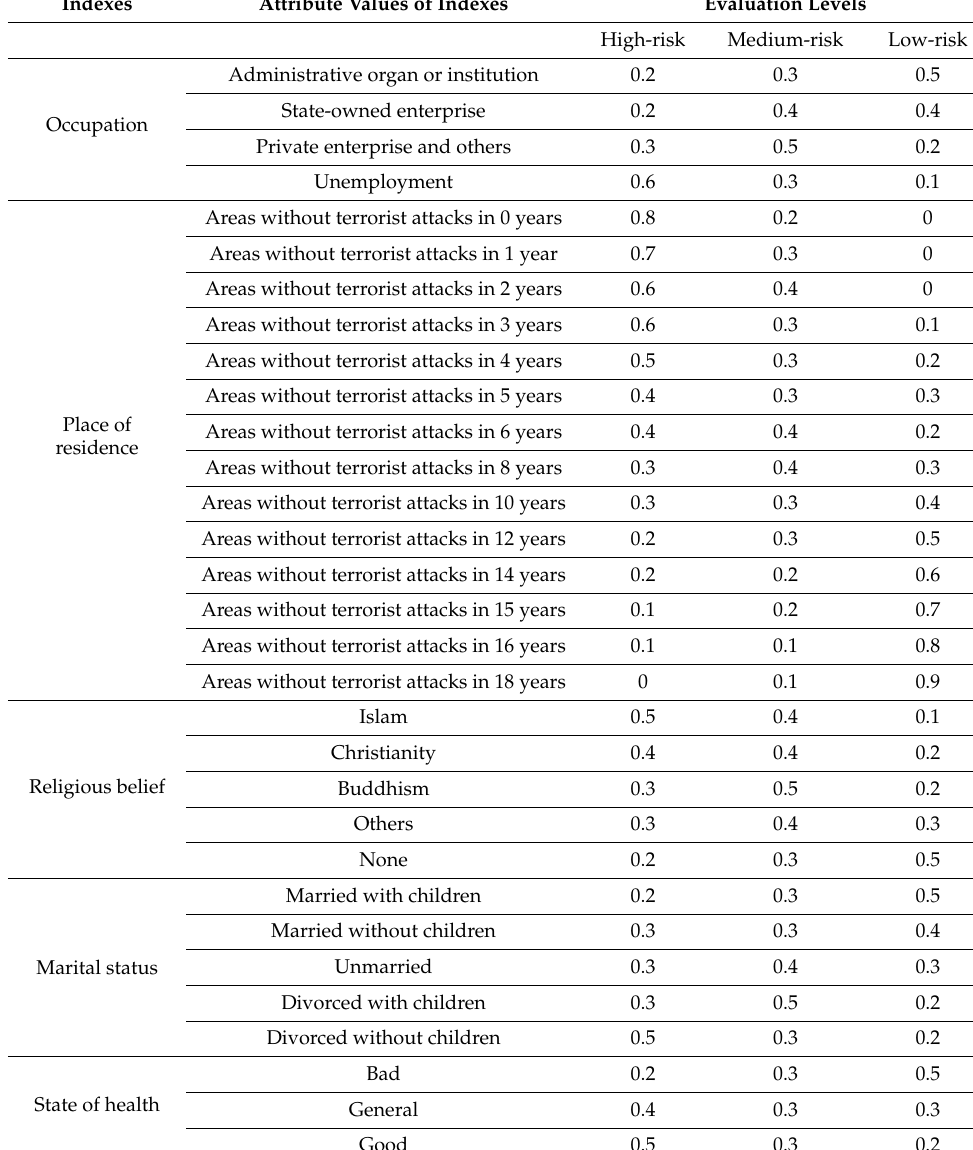
Table A13. Single factor evaluation of personal status